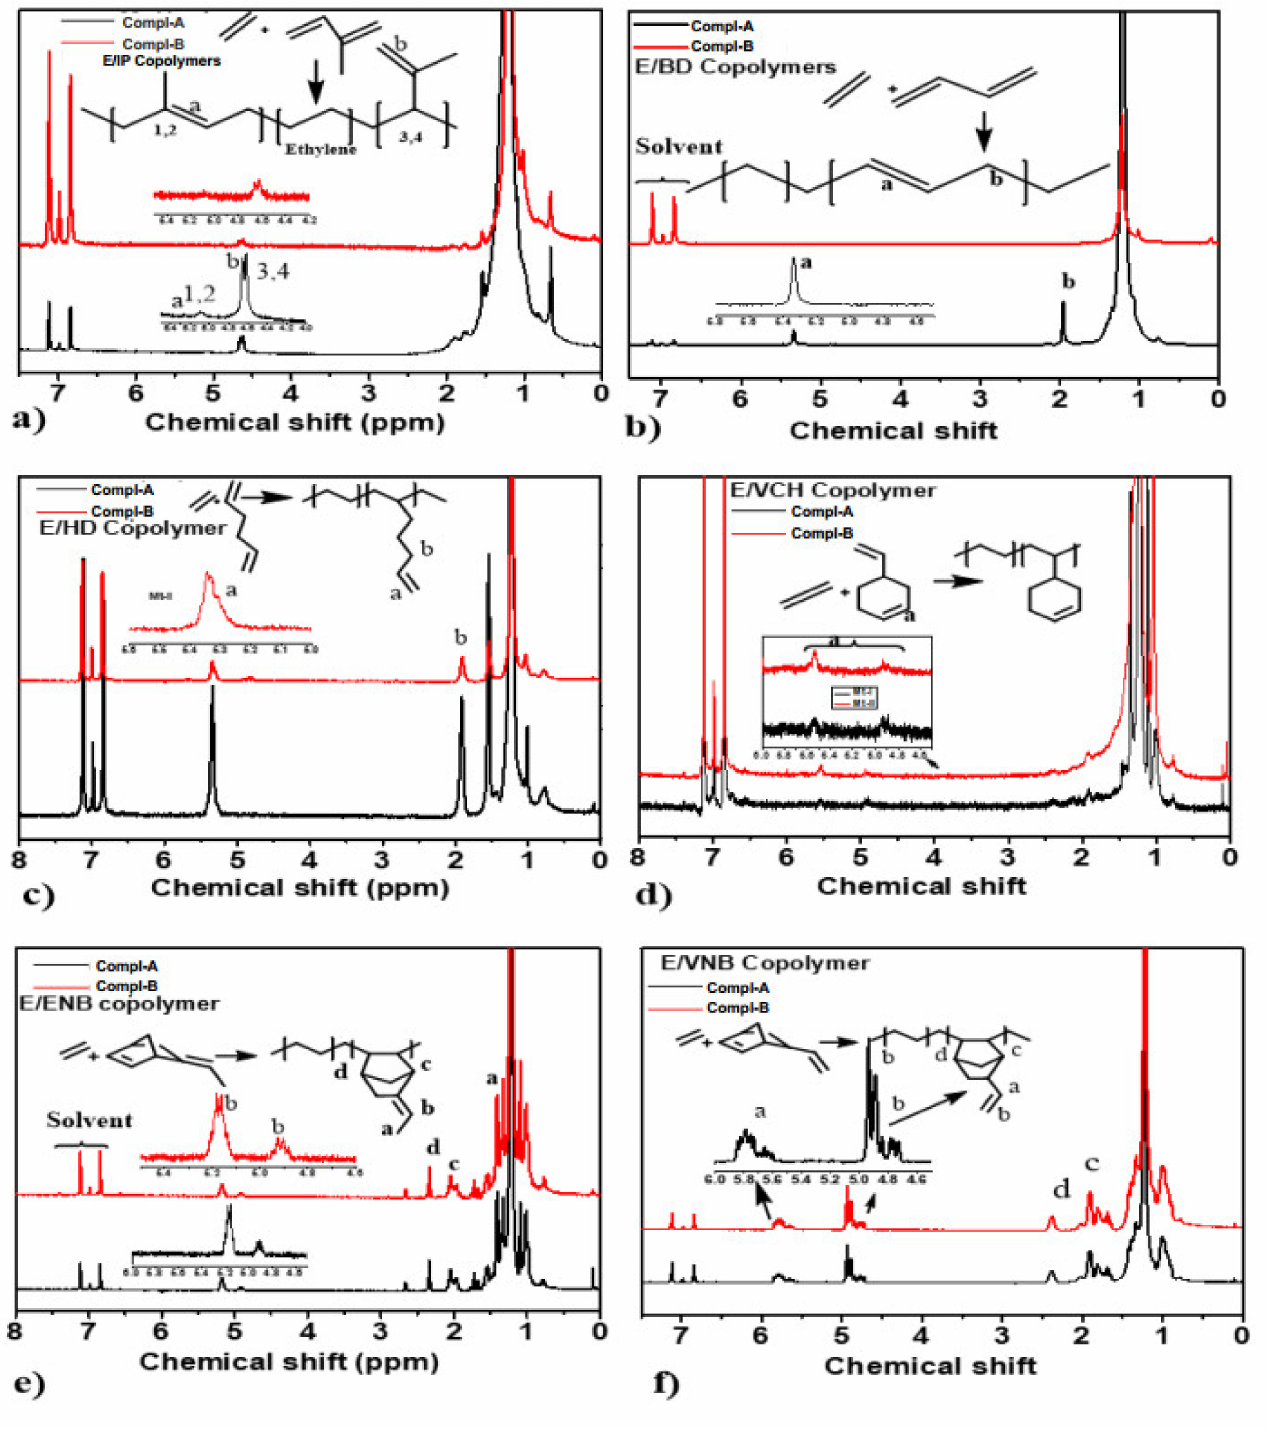
Figure 4. NMR spectra and chain structure of E/diene